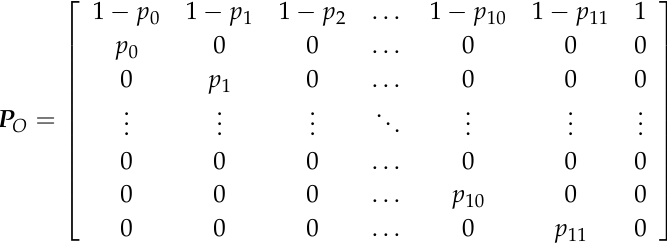
The columns of P O correspond to the 13 state × stage categories (live (Egg, 1st, 2nd, 3rd, 4th, 5th, Pupa), newly dead (1st, 2nd, 3rd, 4th, 5th), dead) at time t. The rows of P O represent the possible states and stages an individual can be observed as at time t (not observed, live (Egg, 1st, 2nd, 3rd, 4th, 5th, Pupa), newly dead (1st, 2nd, 3rd, 4th, 5th)). The sub-diagonal of P O contains the probabilities of